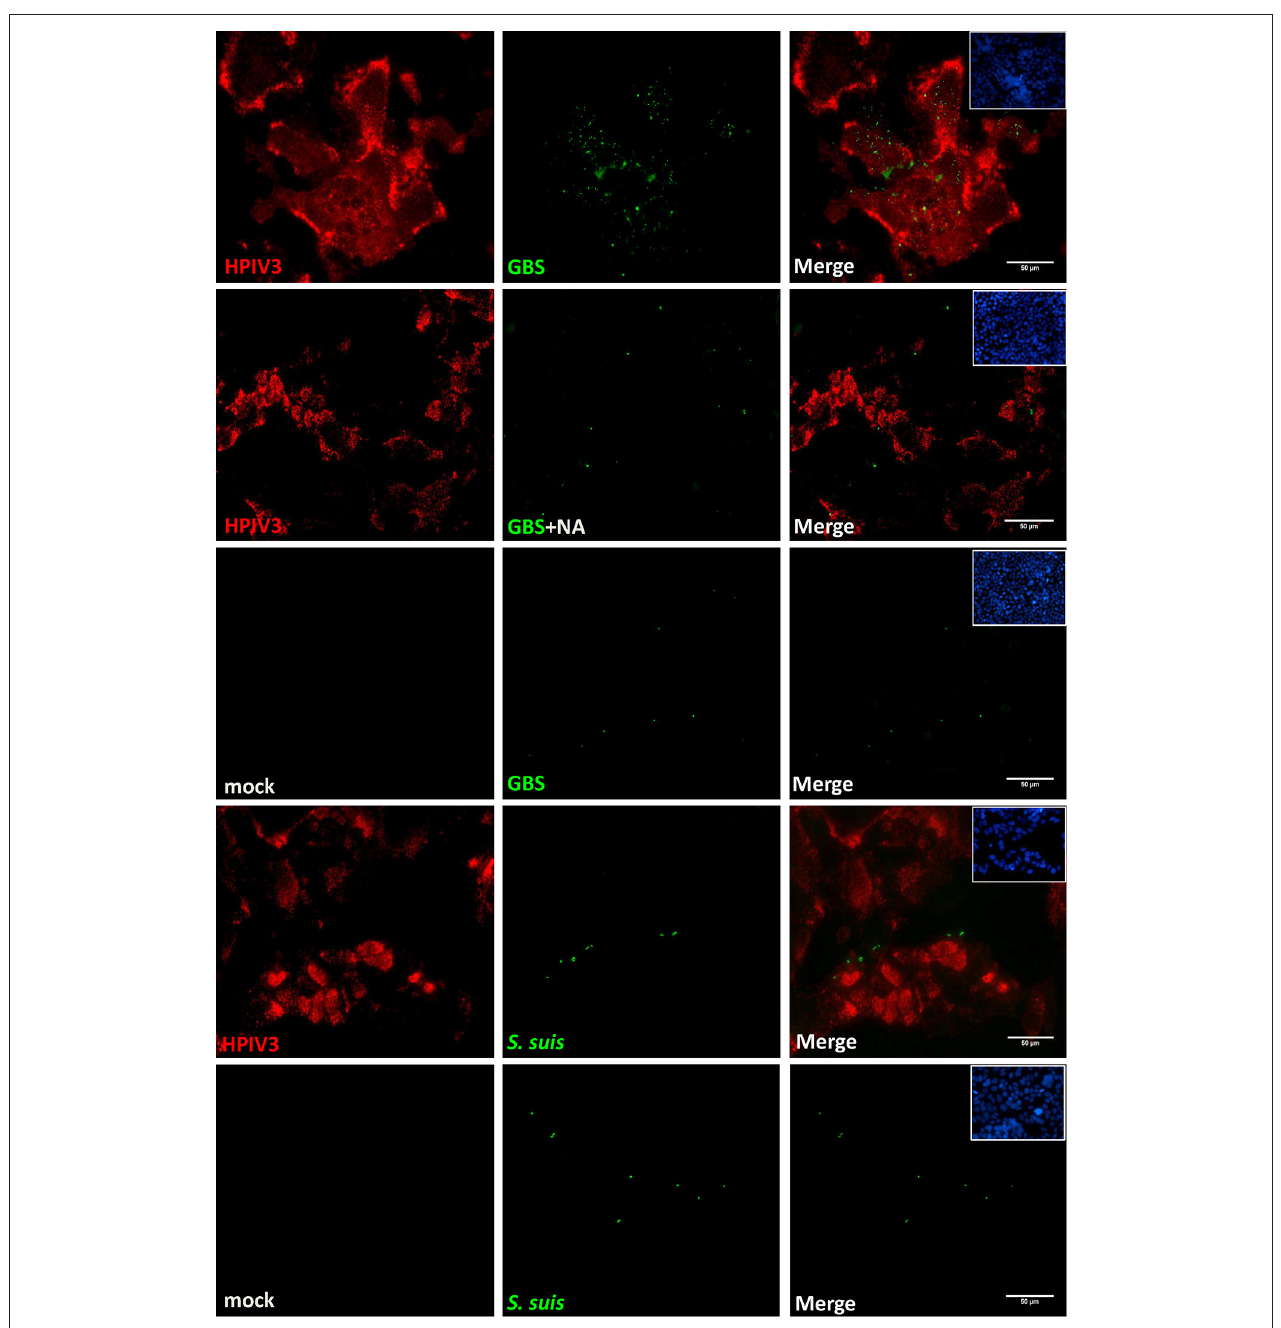
FIGURE 2 | Immunofluorescence analysis of streptococcal attachment to HPIV3-infected cells. HEp-2 cells infected by HPIV3 were inoculated at 16h.p.i. with GBS or S. suis or neuraminidase-treated GBS (GBS + NA) and incubated for 1h at 4 ◦ C. Bound bacteria (green) and HPIV-infected cells (red) were immune-stained with specific polyclonal antibodies. All experiments were repeated at least three times with duplicate samples. Scale bars represent 50 µ m.